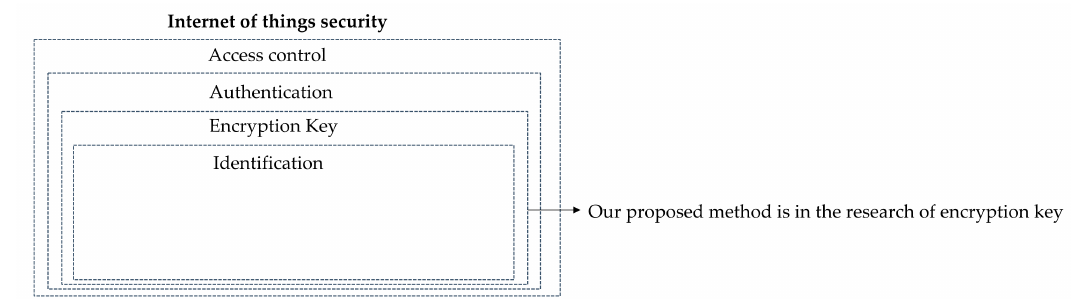
Figure 16. Internet of Things